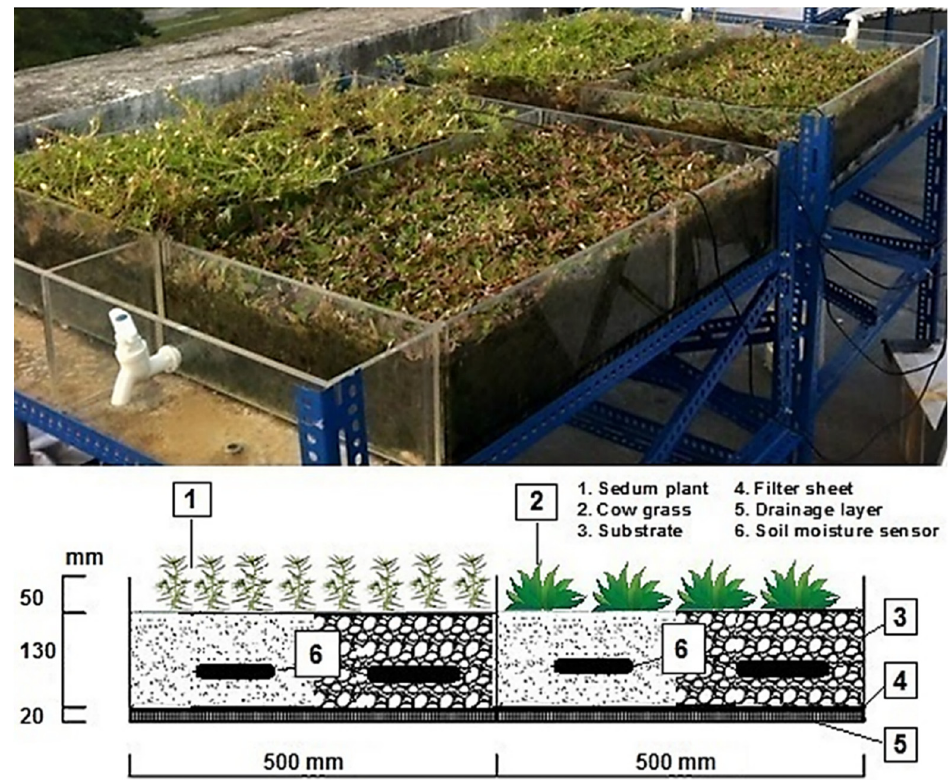
Figure 1. Experimental green roof test beds with sedum & grass plant species.